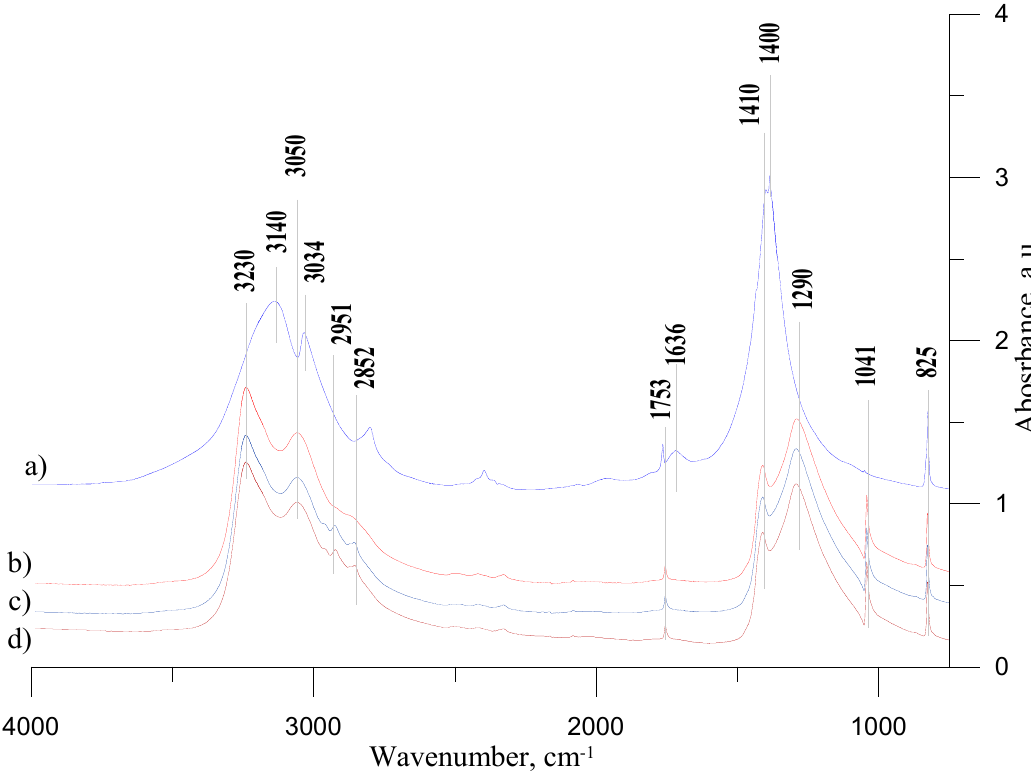
Figure 3. FT-IR spectra of: ( a ) ANFO, ( b ) AN-PP, ( c ) non-ideal explosive with ca. 1.0% of MC, and ( d ) non-ideal explosive with ca. 3.0% of MC.